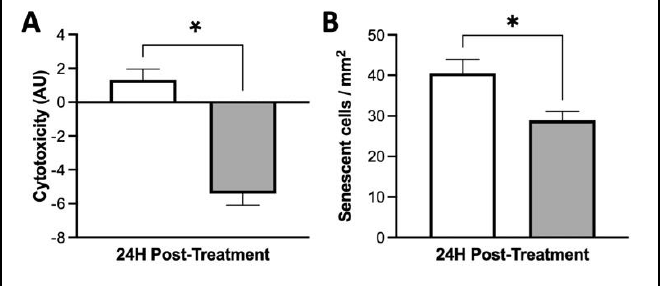
Figure 4. MIS supports whole-cell health by decreasing ( A ) cytotoxicity and ( B ) cellular senescence in fibroblasts after 24 h of treatment. White bars indicate CON treatment, grey bars indicate MIS treatment. n = 3 independent donor biopsies per group. Data are mean ± SEM. * indicates p < 0.05 via unpaired t -test.